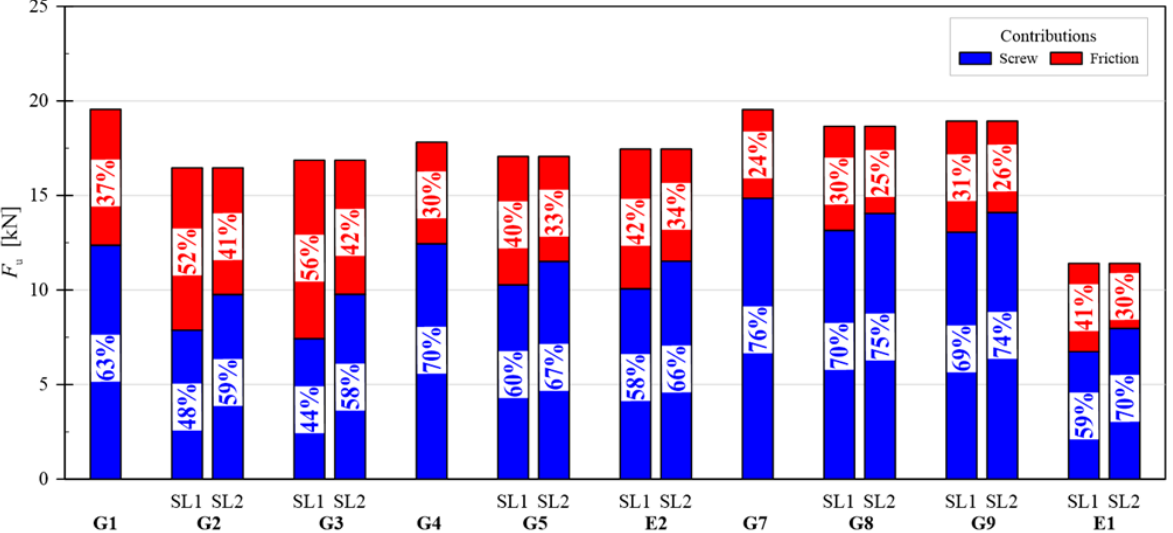
Figure 11. Analysis of 𝐹 𝑢 percentage transferred on the sliding planes through the screw and by friction. Key: SL1 = sliding plane between the concrete member and the interlayer; SL2 = sliding plane between the glulam member and the interlayer.